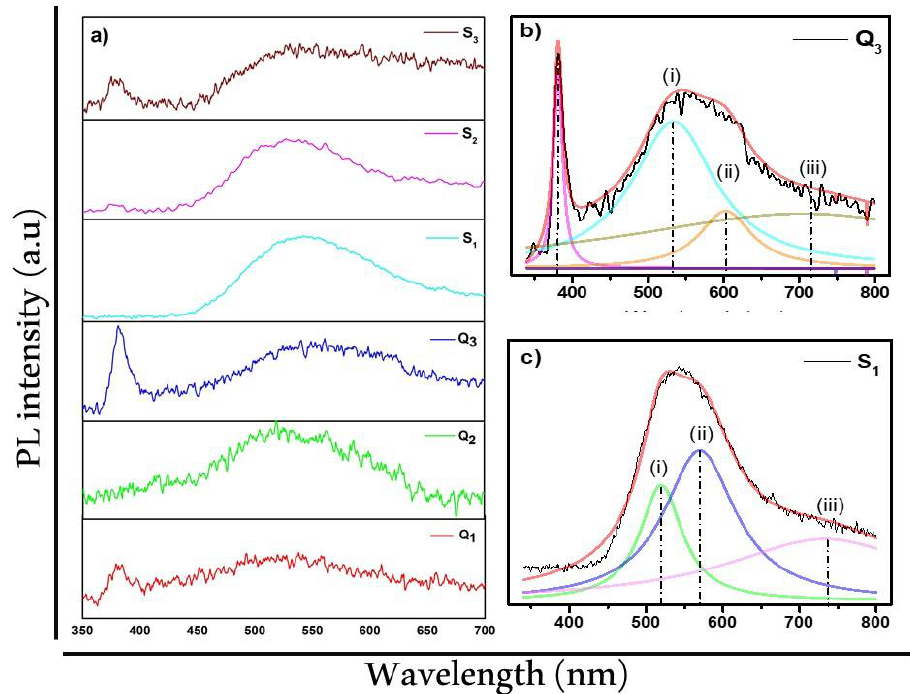
Figure 4. PL spectra of ( a ) the nanoporous ZnO films synthesized at different temperatures on quartz and Si substrates, ( b ) the ZnO film on the quartz substrate when annealed at 800 °C (Q 3 ), and ( c ) the ZnO film on the Si substrate when annealed at 600 °C (S 1 ).